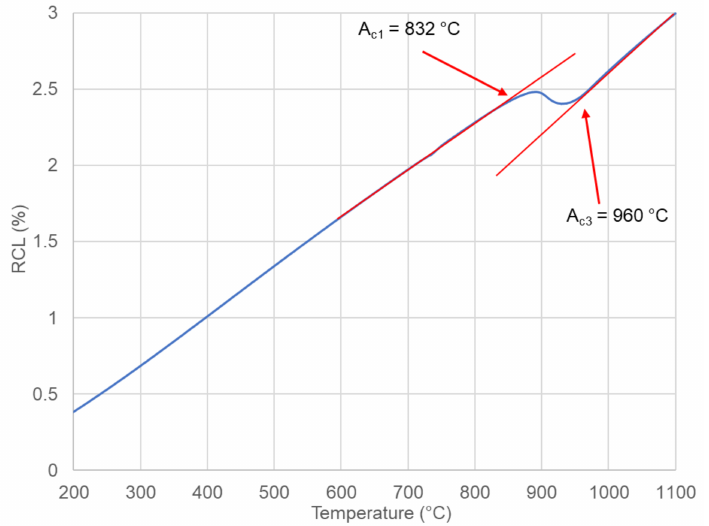
Figure 3. Dilatometry curve during heating for the determination of critical temperatures.